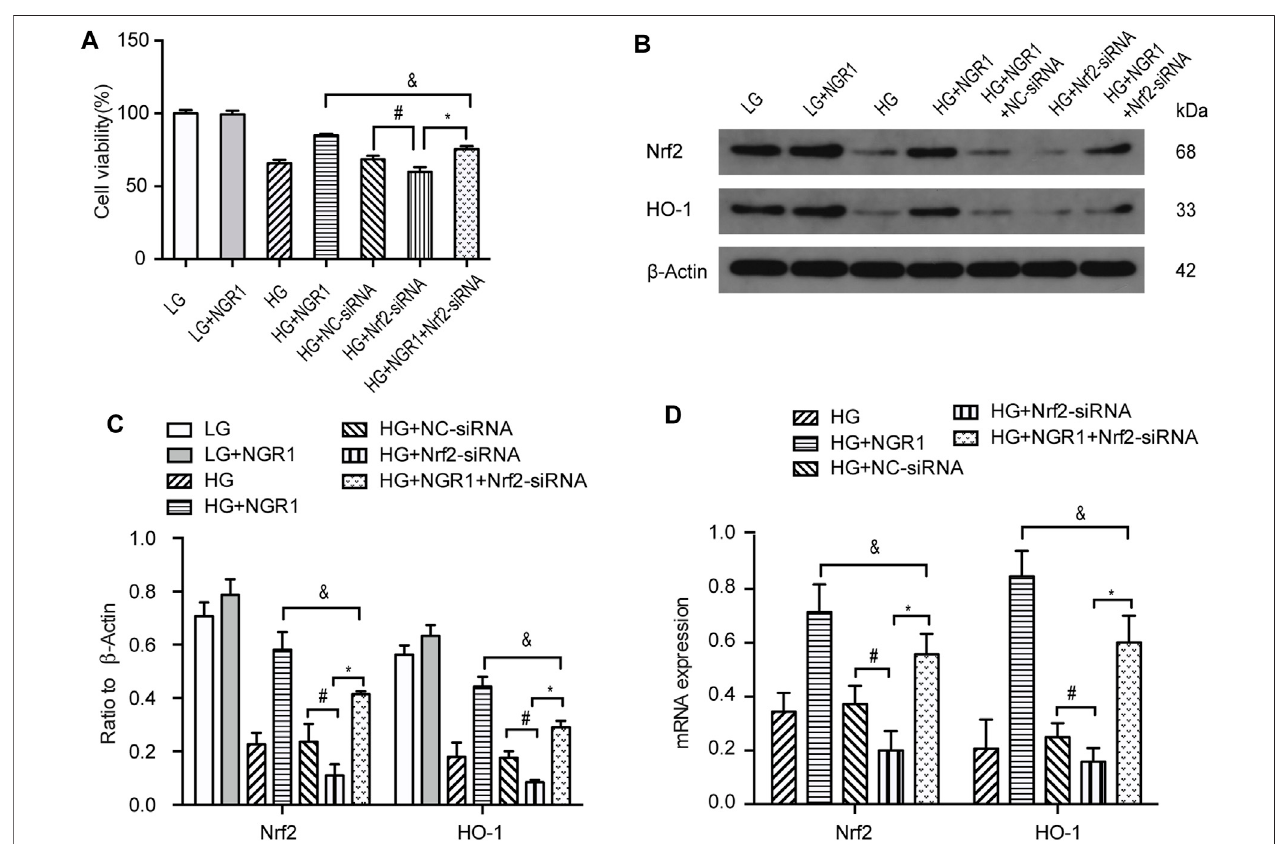
FIGURE 5 | NGR1 exerts its cardioprotective effects via upregulation of AMPK/Nrf2 signaling and HO-1 expression. (A) H9c2 cell viability was reduced by Nrf2 siRNAtransfection. (B) ExpressionofNrf2andHO-1proteinsinH9c2cellsassessedbyWesternblotanalysis (C) DensitometricanalysisofNrf2andHO-1expressionin cardiomyocytes. (D) Nrf2and HO-1 mRNA expression. Dataareshown asmean ± SEMofthree independentexperiments, *p < 0.001, & p < 0.001, and # p < 0.001.LG, 5.5 mM glucose; HG, 30 mM glucose; NGR1, Notoginsenoside R1.